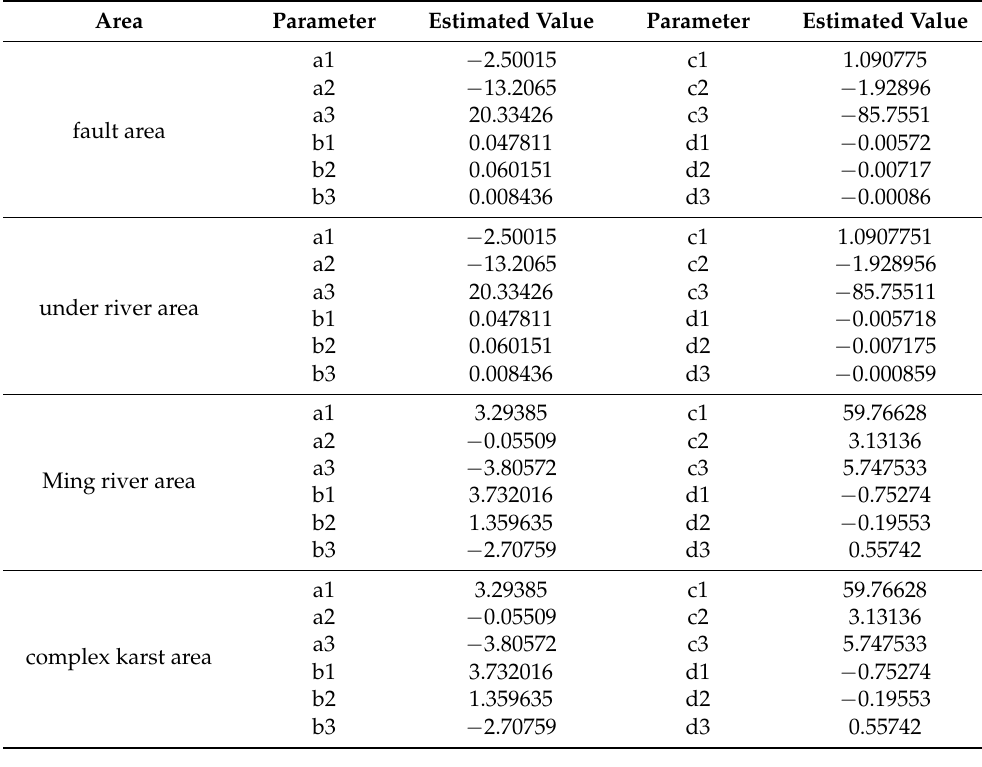
Table 3. Production calculation results.